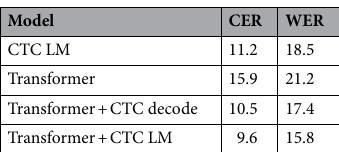
Table 2. Model results on database 2—Conversational telephone